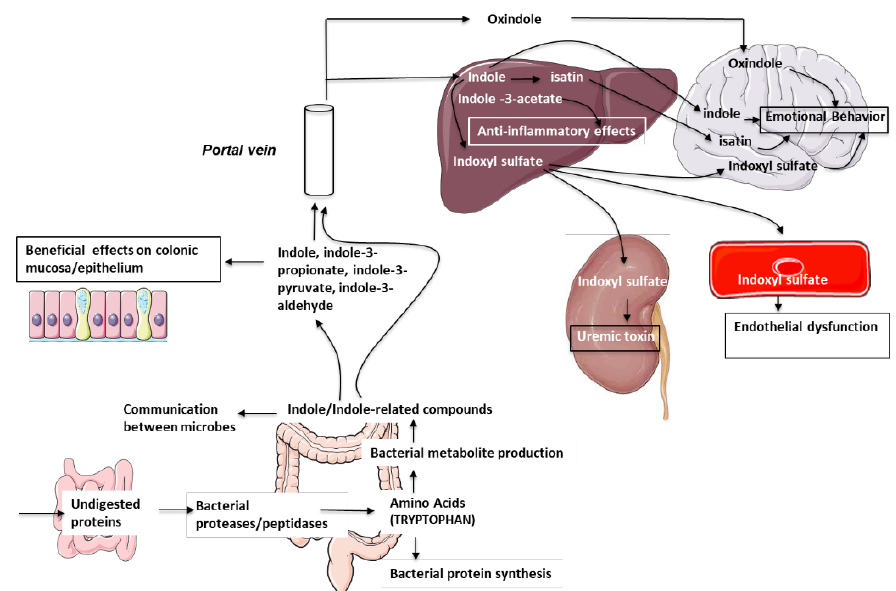
Figure 1. Schematic representation of the effects of indole and indole-related compounds synthesized by the intestinal microbiota on communication between microbes, and effects of bacterial metabolites and co-metabolites on host tissues. A minor portion of undigested or partially digested dietary and endogenous proteins is transferred from the small to the large intestine. There, these nitrogenous compounds are intensively degraded into their amino acid constituents by bacterial proteases and peptidases. The amino acids, including tryptophan, are used for microbial protein synthesis and bacterial metabolism, releasing numerous compounds into the luminal content. Tryptophan metabolism by specific bacterial species releases indole and several indole-related compounds. Several of these compounds are implicated in communication between intestinal microbes. The indolic compounds indole, indole-3-propionate, indole-3-pyruvate, and indole-3-aldehyde have been shown in experimental models to exert beneficial effects on the intestinal mucosa/epithelium in different physiological and pathophysiological situations. Indole and related compounds are then transferred from the lumen to the portal blood and reach the liver. In the liver, indole is partly metabolized into indoxyl sulfate. Although indole and indole-3-acetate have been shown in pre-clinical studies to exert anti-inflammatory effects on liver cells, indoxyl sulfate released from the liver has been clearly identified as a uremic toxin that is deleterious for kidney tubular cells, thus accelerating chronic kidney disease. In addition, indoxyl sulfate exerts deleterious effects on the endothelium, and is thus one element involved in endothelial dysfunction. Emerging experimental data suggest that indole, indoxyl sulfate, isatin, and oxindole are 4 indolic compounds that enter the brain by unknown mechanisms, exerting there, depending on the dose used, either beneficial or deleterious effects on brain activity and emotional